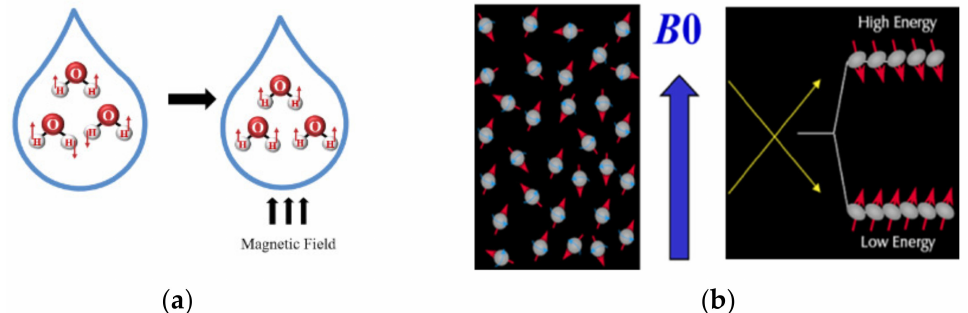
Figure 1. Effect of magnetic field on water molecules: ( a ) Reorientation of proton spin under magnetic field effect; ( b ) sketch of energy-level splitting of hydrogen